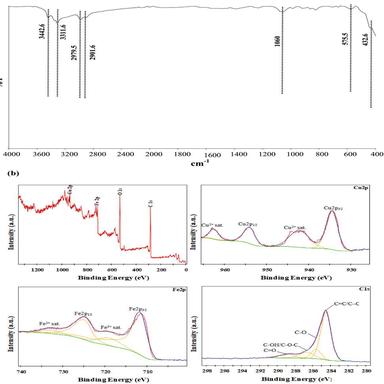
(a) FTIR spectrum, (b) XPS spectra of FLPWAC composite.